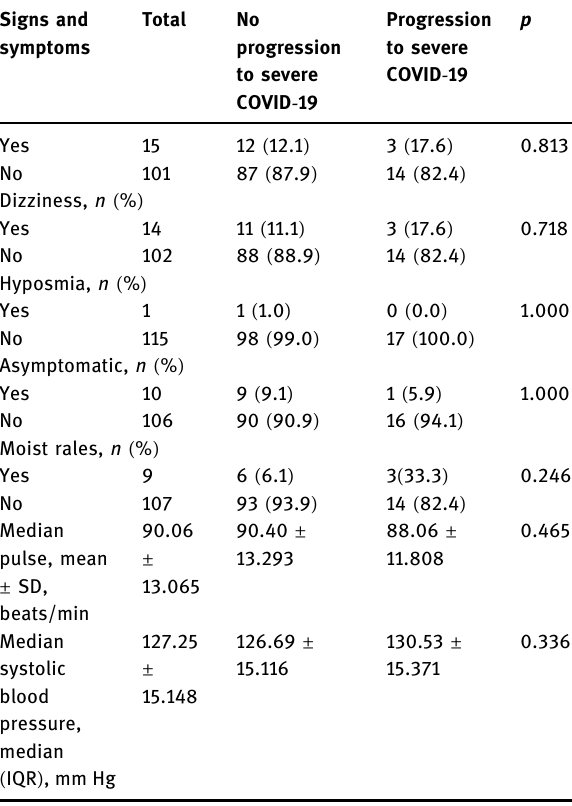
Table 2: Clinical manifestations of patients with COVID - 19 at hospital